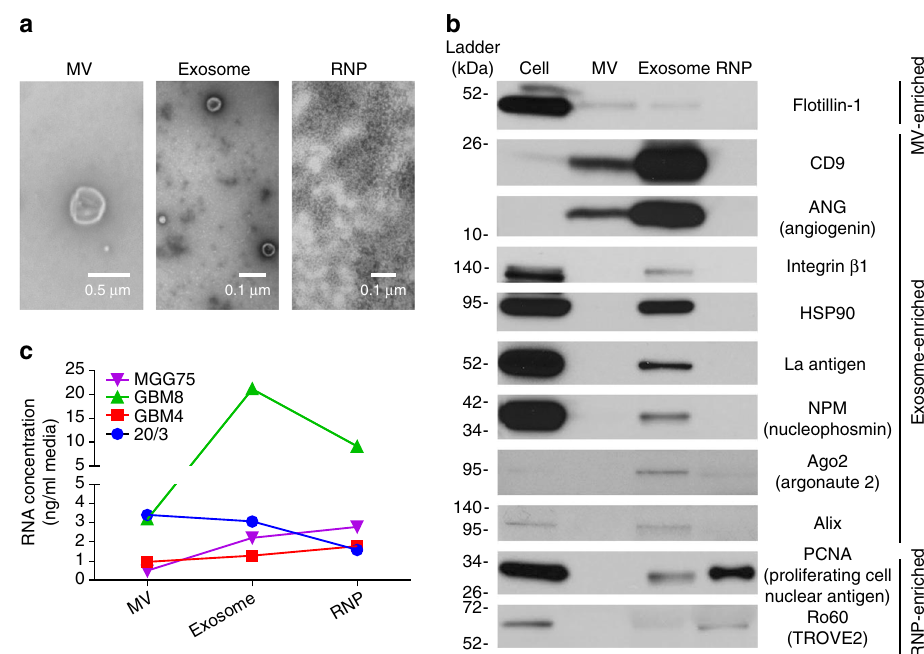
Fig. 2 Quality control of the fraction separation. a Transmission electron microscopy of EVs and RNPs isolated using the sequential fi ltration protocol. TEMs were replicated three times. b Protein markers, identi fi ed by the western blotting, veri fi ed the separation of extracellular fractions. Equal protein input of 50 μ g per lane was used. Western blots were replicated twice. c RNA yields of extracellular fractions from different GSC